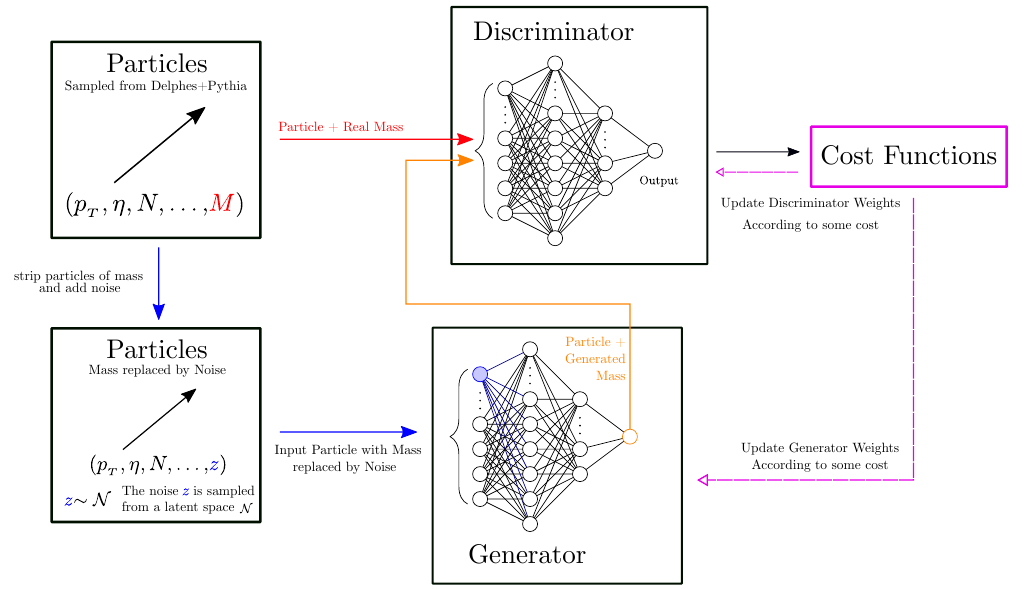
Figure 1 . Flowchart describing how GANs are used to learn templates (shown here mass templates for the RPV-SUSY search) given kinematic variables. The generator network is a feed-forward network that takes as input particles with their mass replaced by noise, and generates mass according to a learnt distribution. These fake particles are bundled with real particles and passed to the discriminator, which learns to discriminate between the real and fake